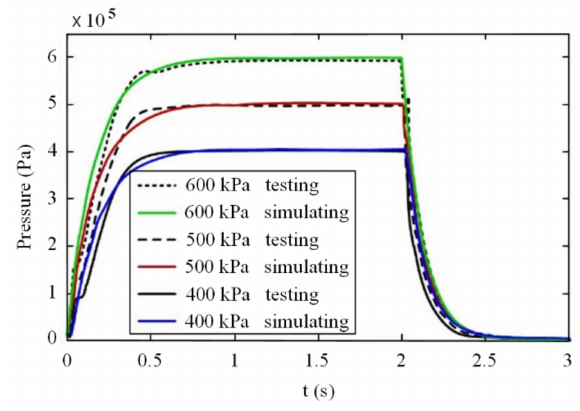
Figure 6. Verification of the simulation model for the pressure regulation characteristics.